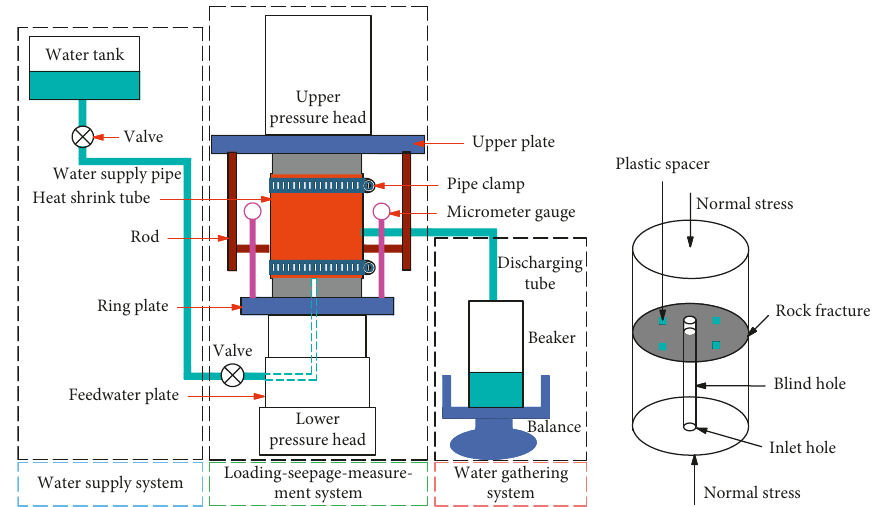
Figure 2: Schematic sketch of the (a) radial flow testing system and (b) specimen in test.